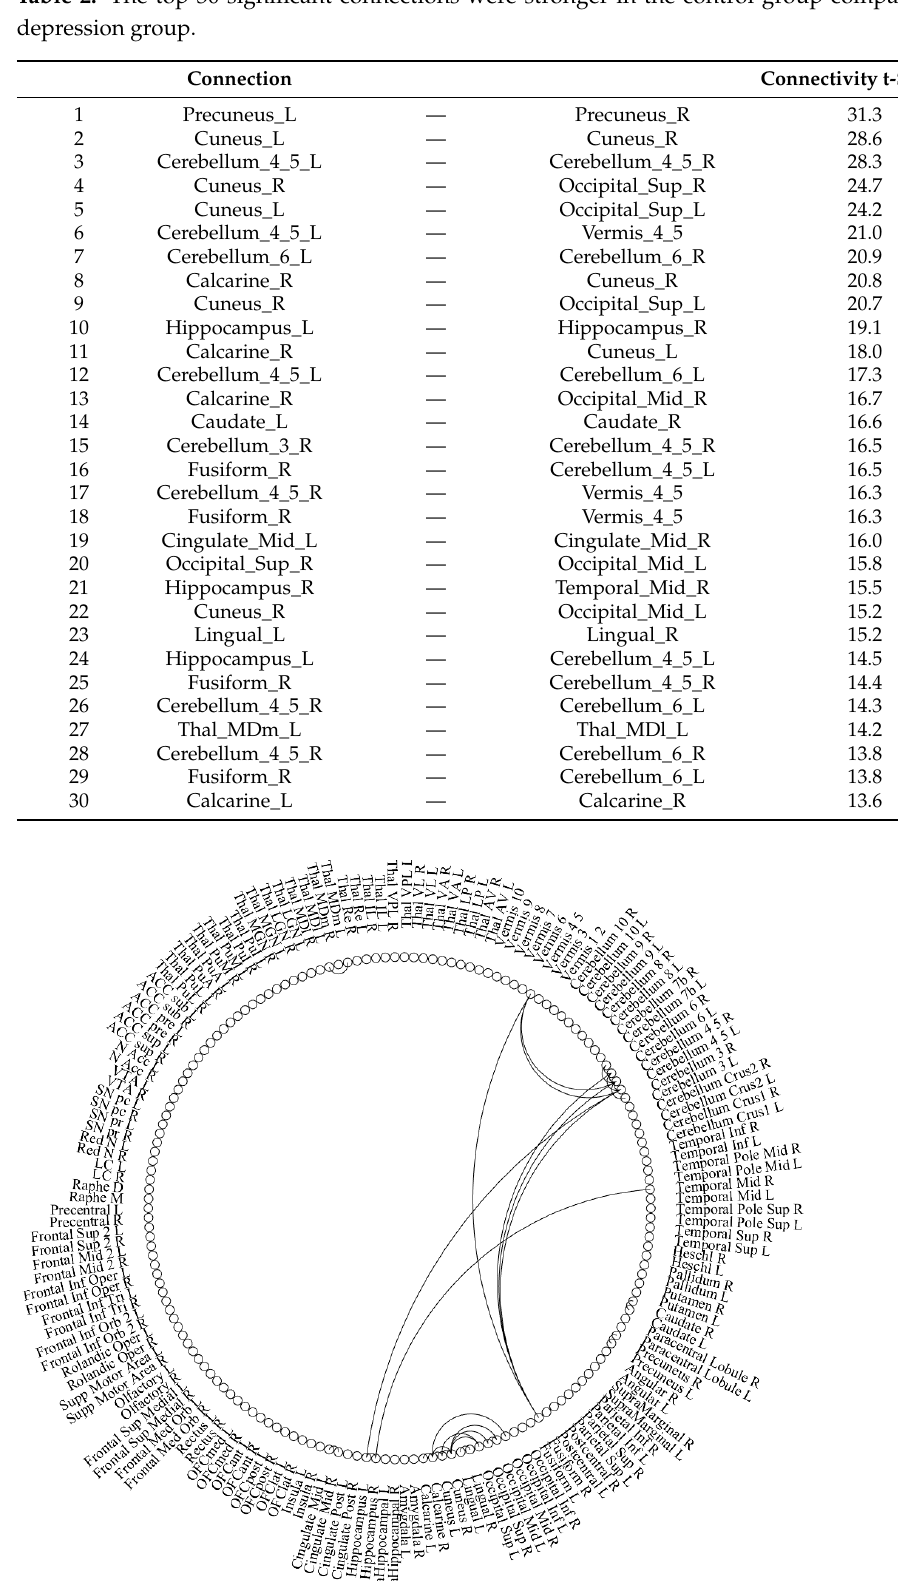
Figure 1. Illustration of the top 30 significant connections were stronger in the control group com- pared to the depression